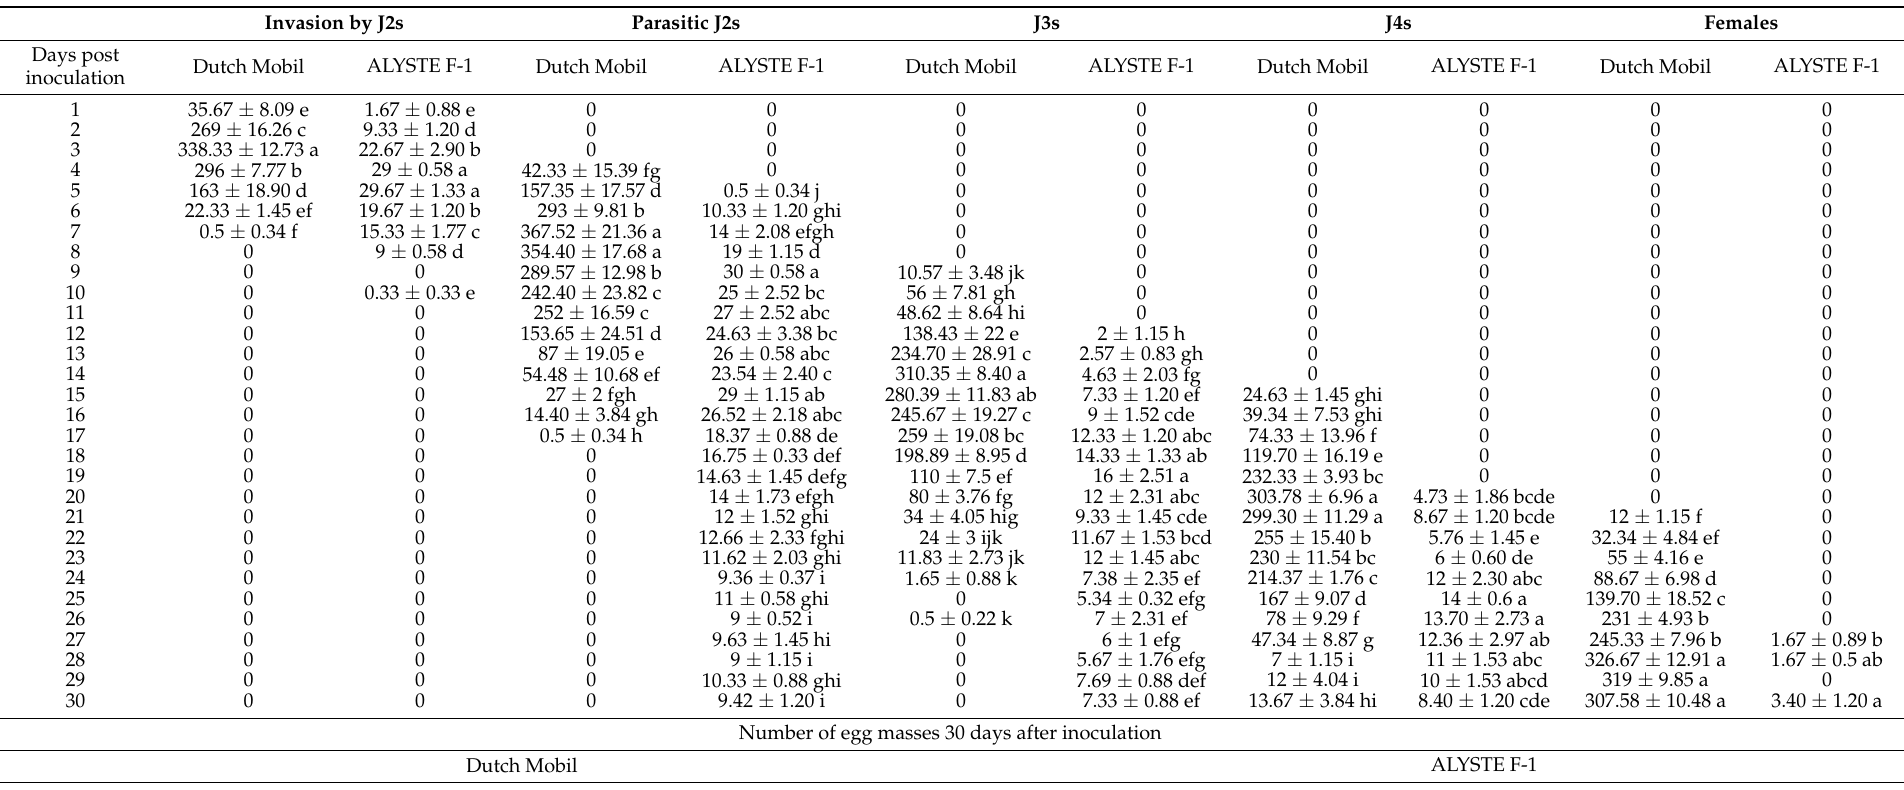
Table 2. Comparison of Meloidogyne javanica invasion, development, and reproduction in highly susceptible and moderately resistant tomato cultivars (Dutch Mobil and ALYSTE F-1, respectively). Invasion by J2s J3s J4s